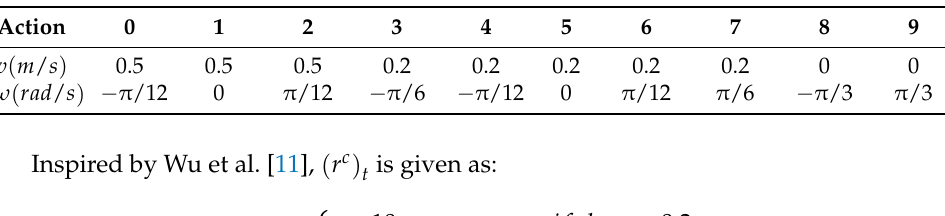
Table 1. Action space defined in this